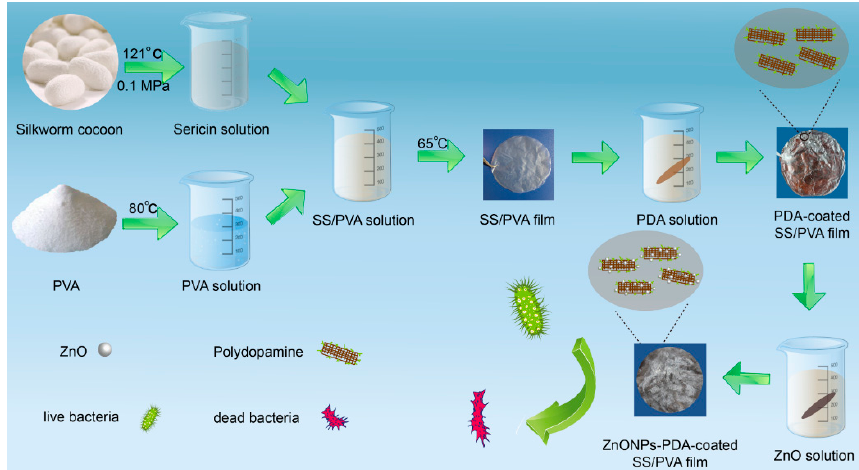
Figure 1. Schematic diagram of the preparation and antibacterial action of ZnO NPs-PDA-SS/PVA film.